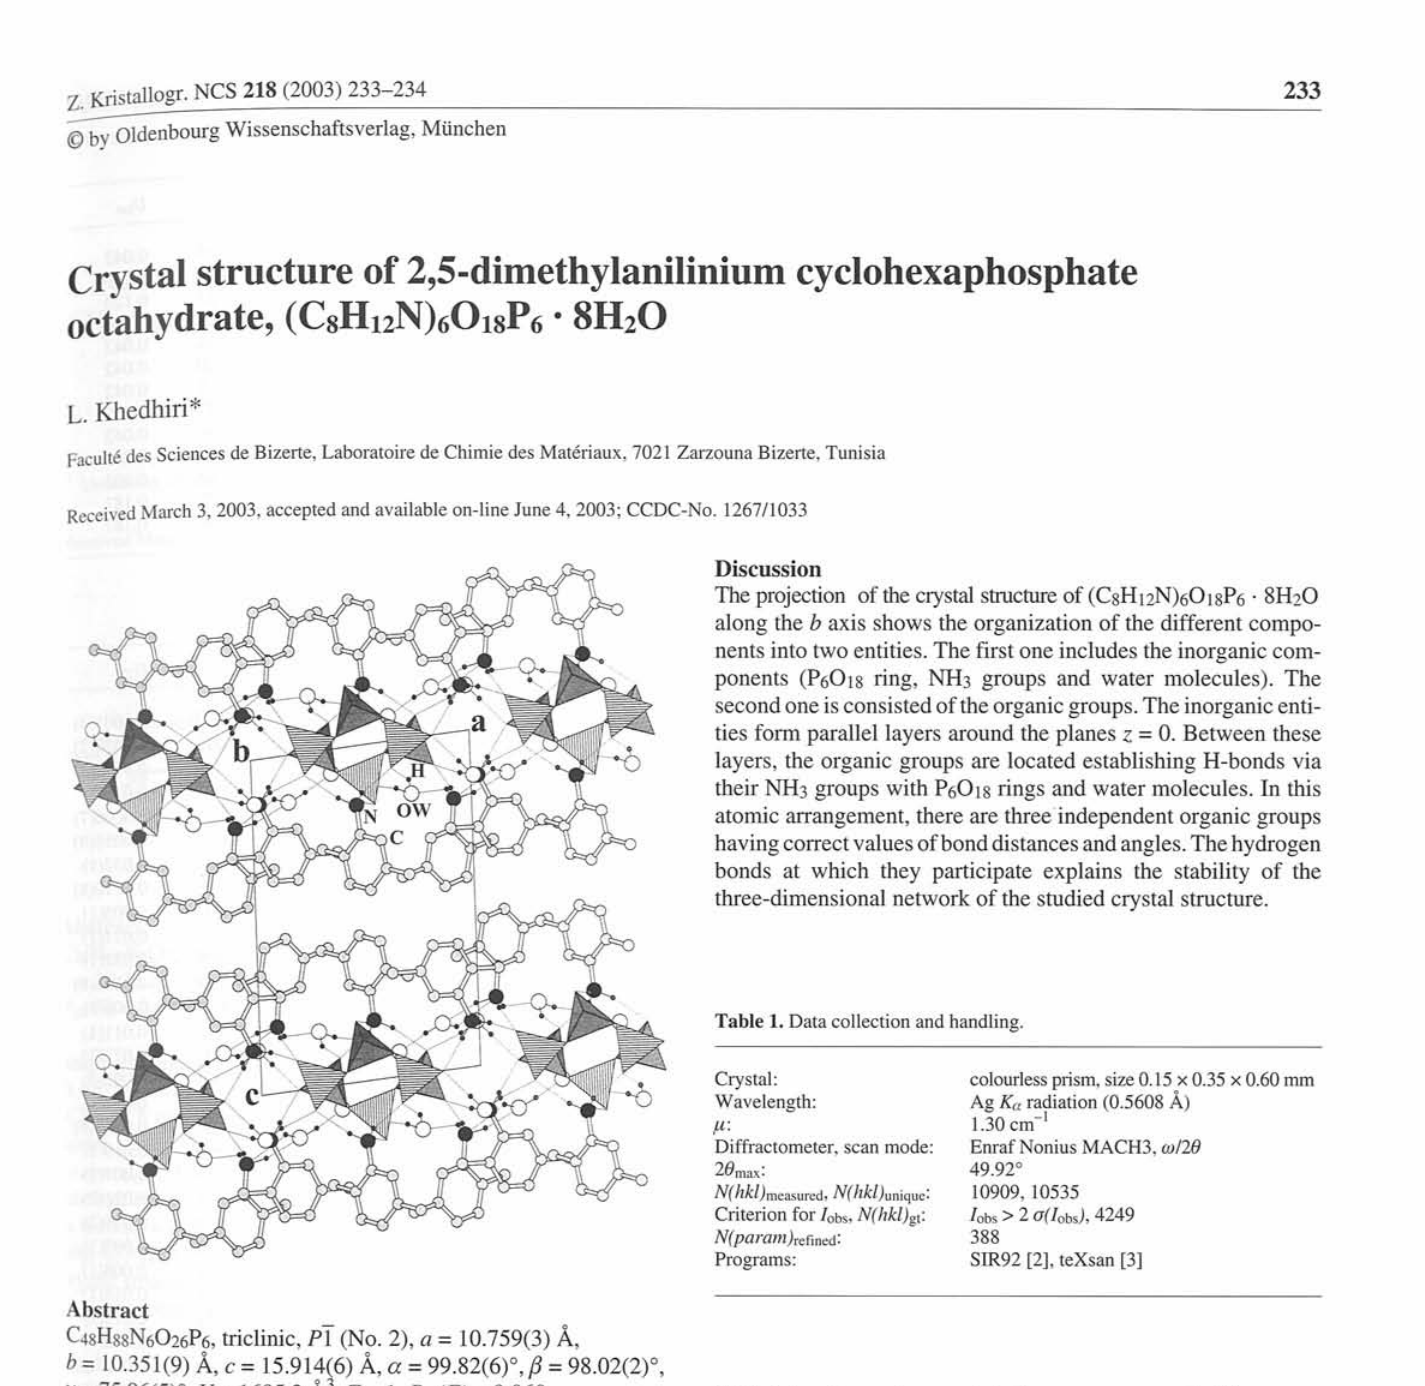
Table 2. Atomic coordinates and displacement parameters (in Â 2